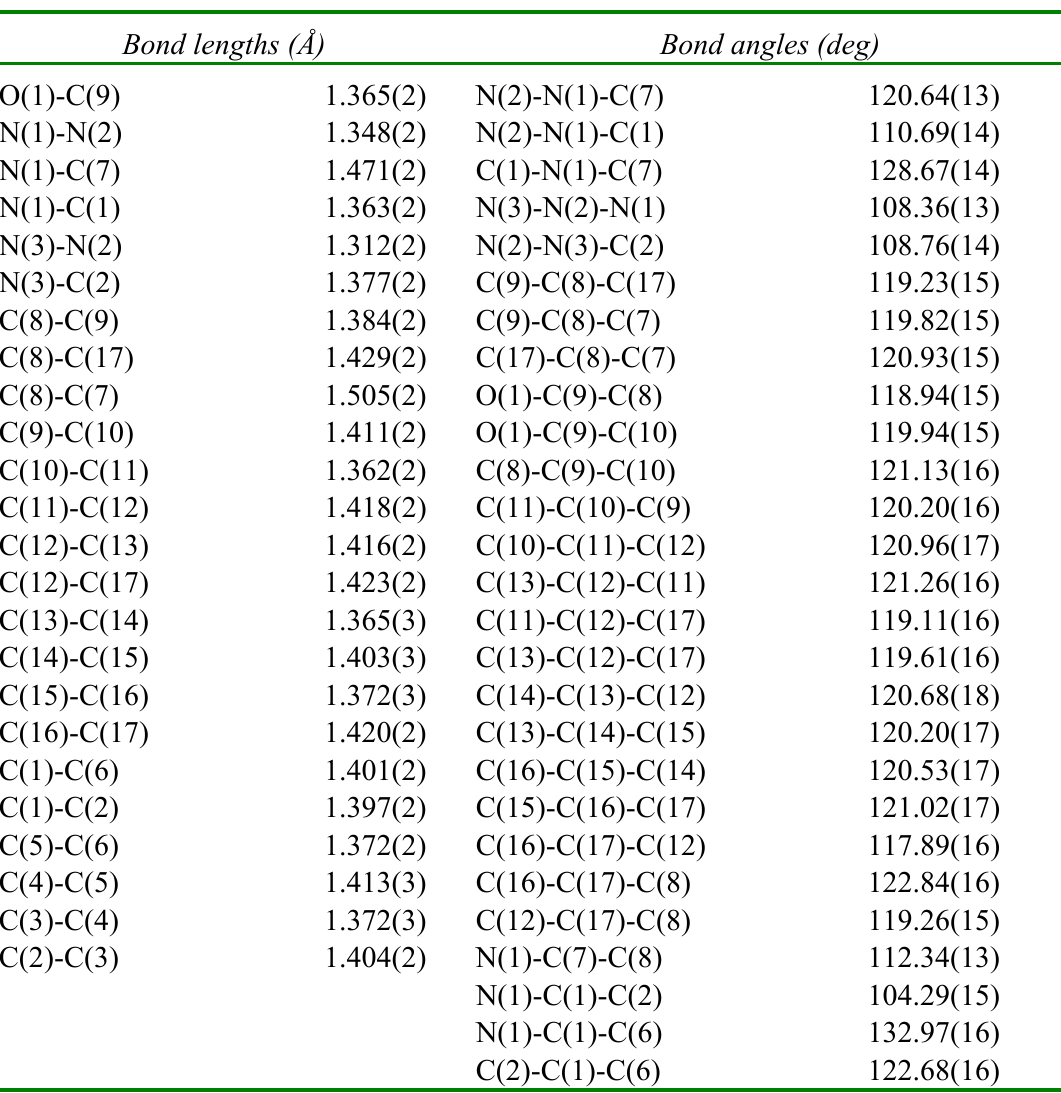
Table 1. Structural characteristics of 6 .